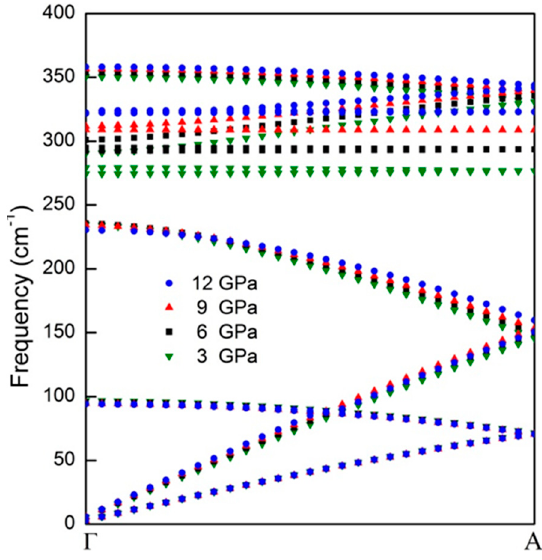
Figure 8. Phonon dispersion curves of WZ ZnS at zero temperature along the chosen Γ – Α path under different pressures.